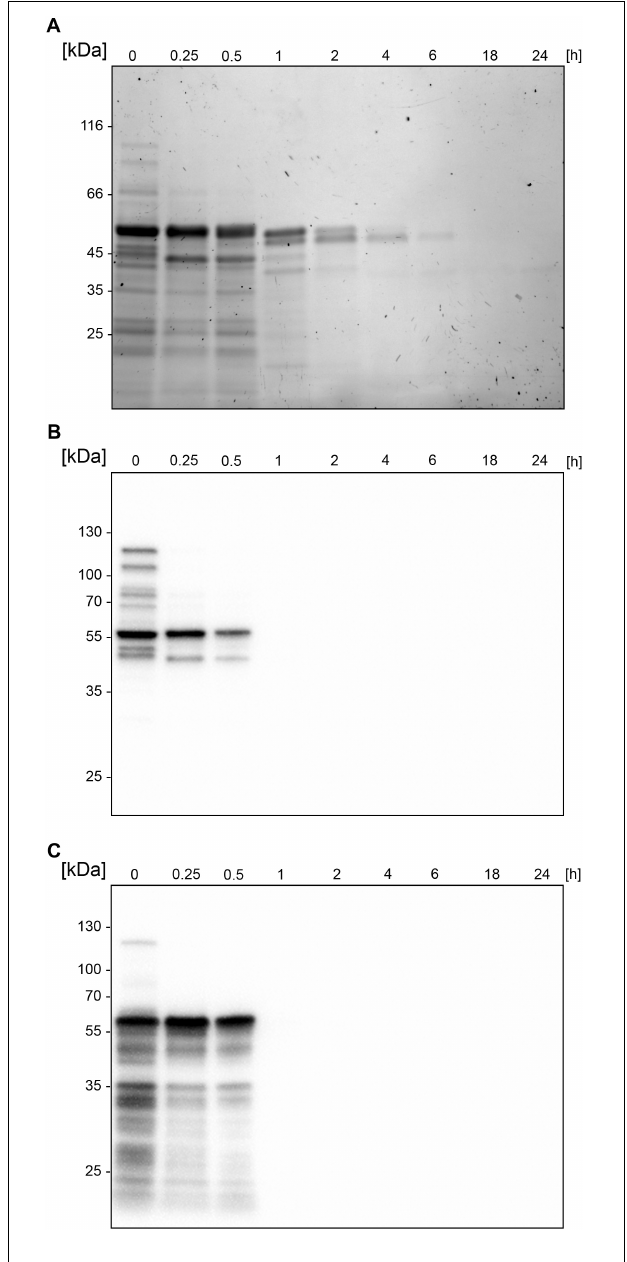
FIGURE 2 | Autoproteolytic activity leads to an immediate fragmentation of BspE. SDS-PAGE and Western blots showing the autoproteolysis of the MBP-BspE-His fusion protein. (A) SDS-PAGE, PAGE-Blue staining showing continuous degradation of the protein (already in starting material). (B) Anti-MBP Western blot showing the gradual loss of MBP-signal over time. (C) Anti-His Western blot showing an immediate loss of the His-signal. The molecular weight of the intact recombinant BspE ∼ 96 kDa; MBP has a molecular weight of 42.5